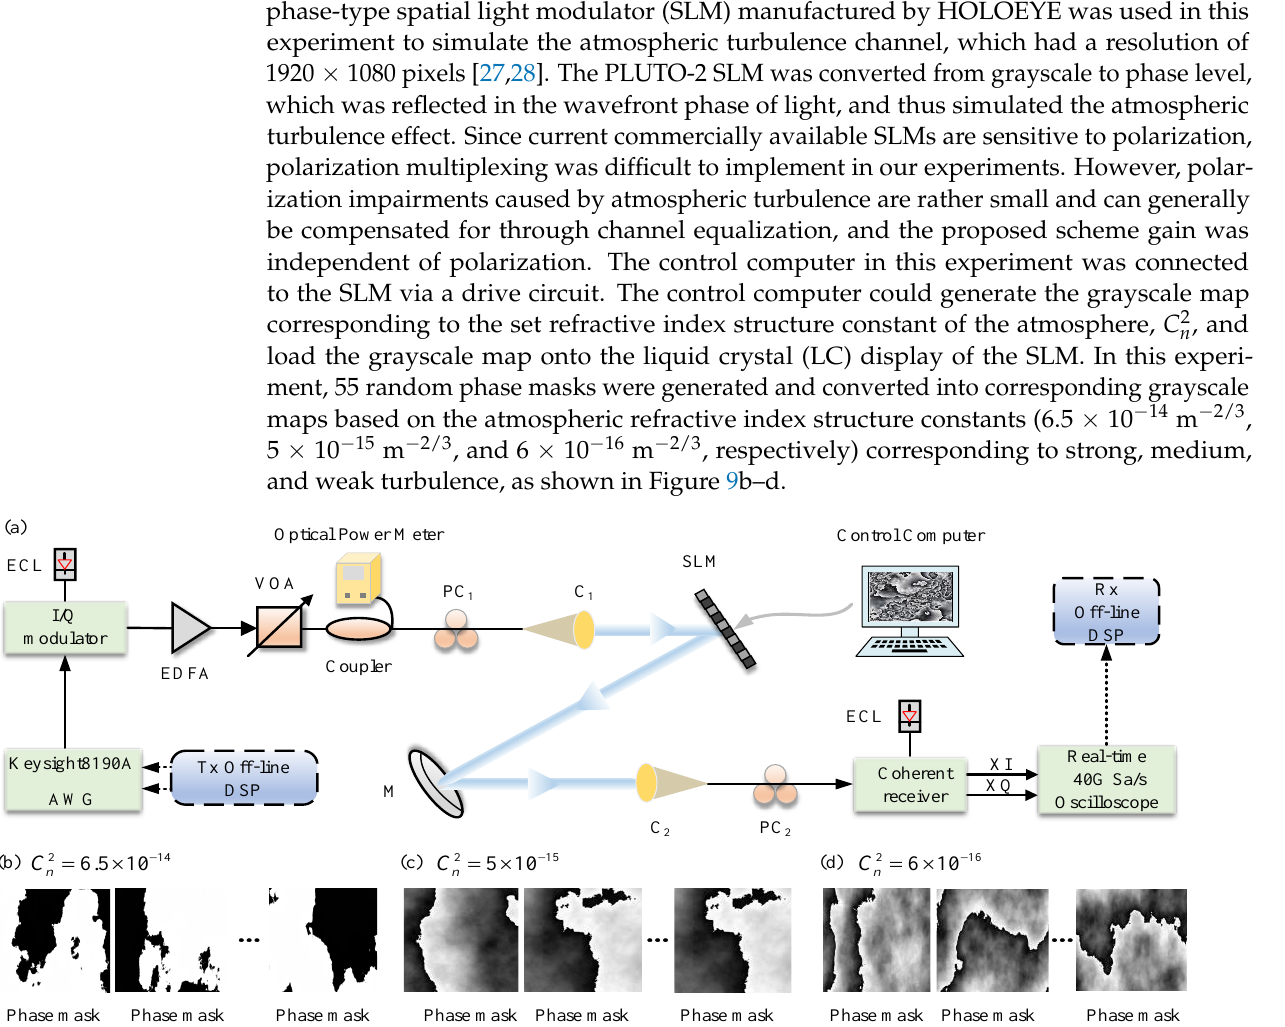
Figure 8. BER as a function of the transmitting power at different linewidths: ( a ) 6.5 × 10 -14 𝑚 −2 3⁄ , ( b ) 5 × 10 -15 𝑚 −2 3⁄ , and ( c ) 6 × 10 -16 𝑚 −2 3⁄ .